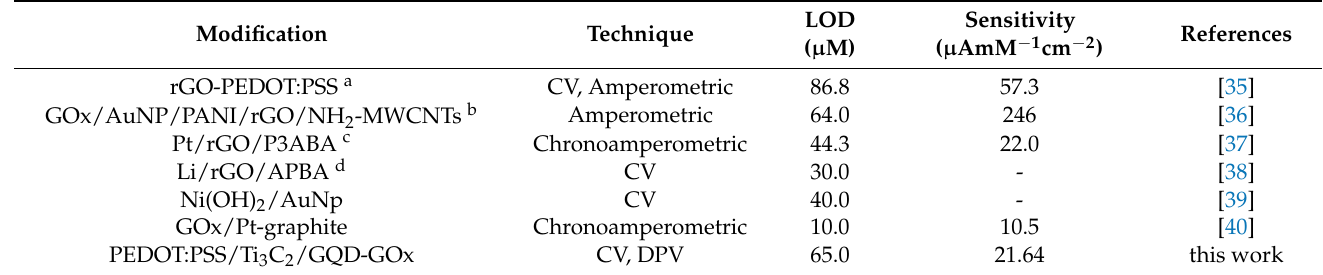
Glucose detection on modified electrode; a reduced graphene oxide (rGO); b multiwalled carbon nanotubes (MWCNTs); c poly(3-